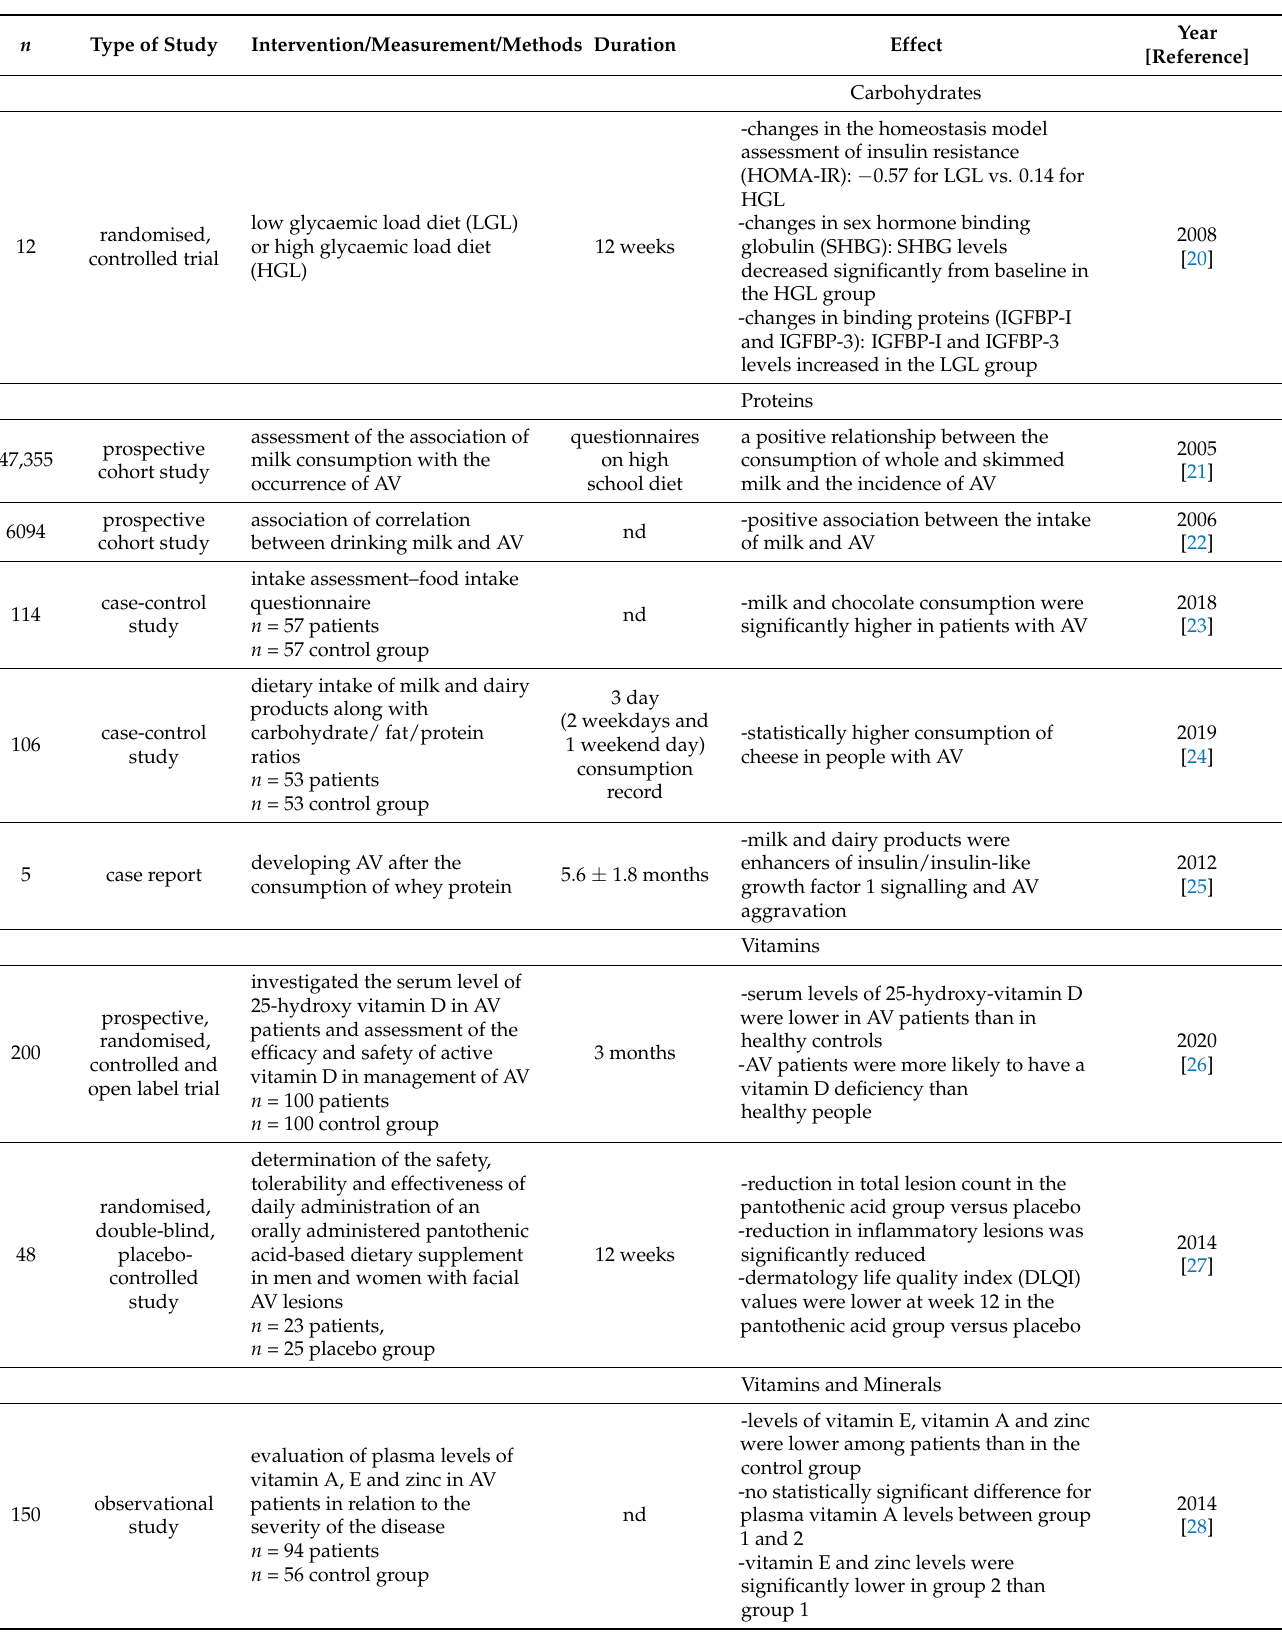
Table 2. Characteristics of publications on topics that were not found in the database during the literature